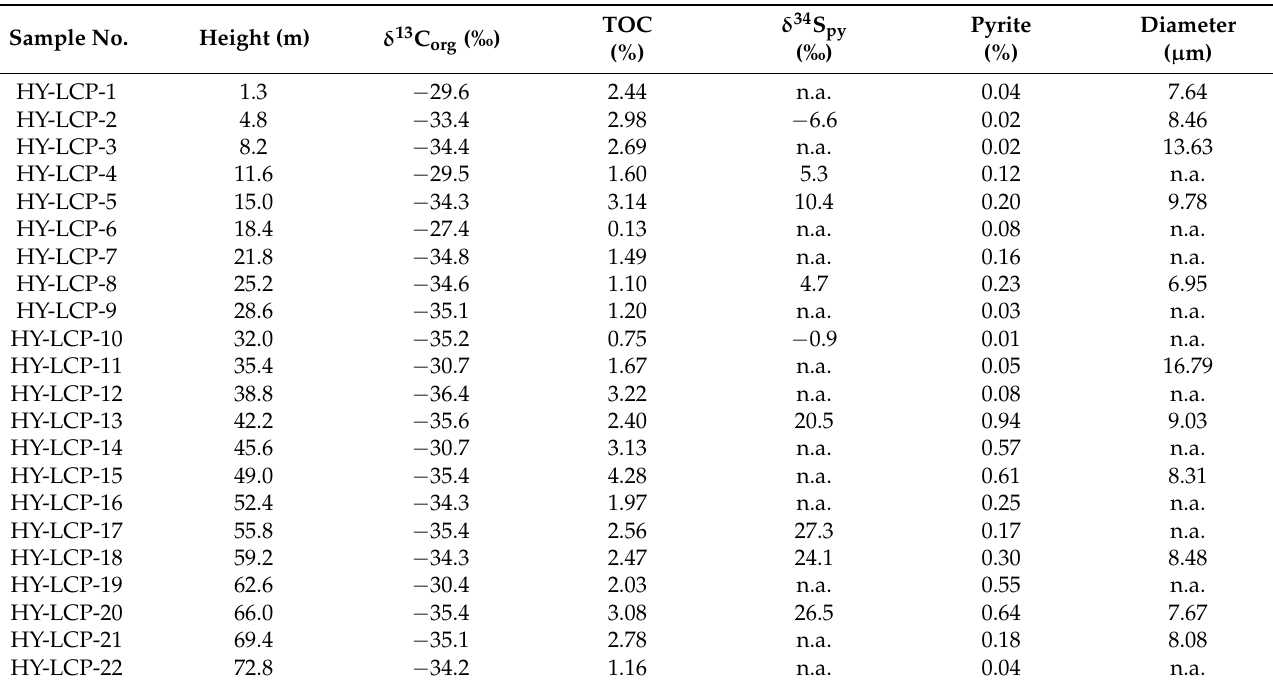
Table 1. Geochemical results from the Dengying